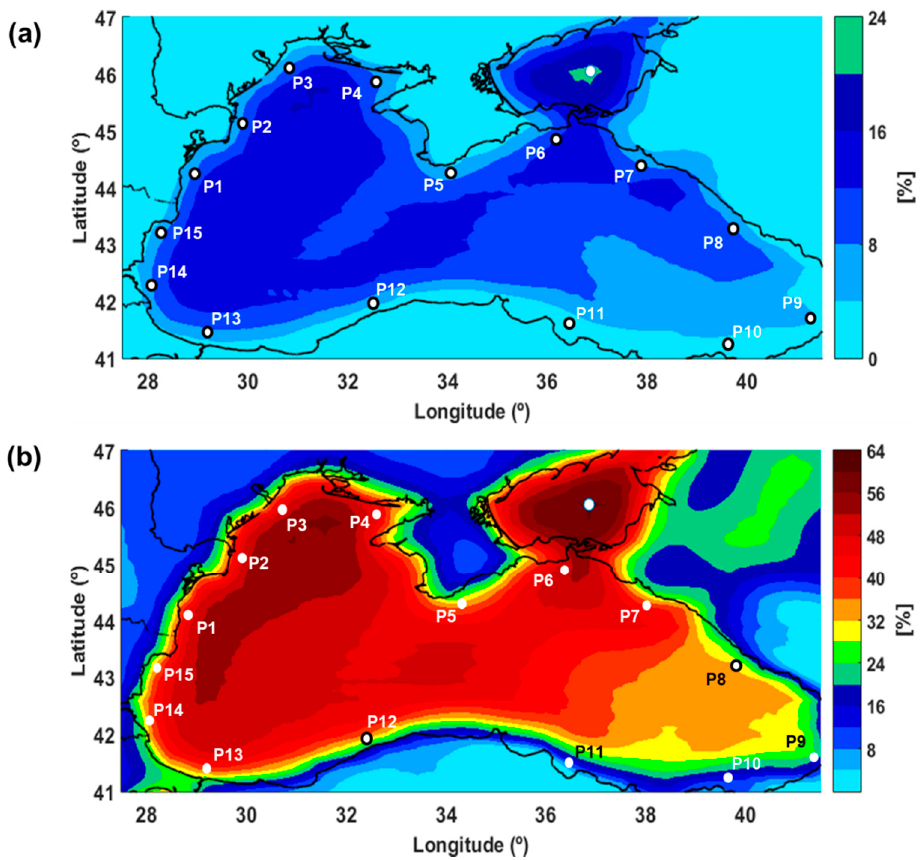
Figure 5. The spatial distribution of the wind speed, considering the entire 30-year period (1987–2016) of NCEP data. Results reported for: ( a ) U 10 > 10 m/s (in %); ( b ) U 10 > 6m/s (in %).